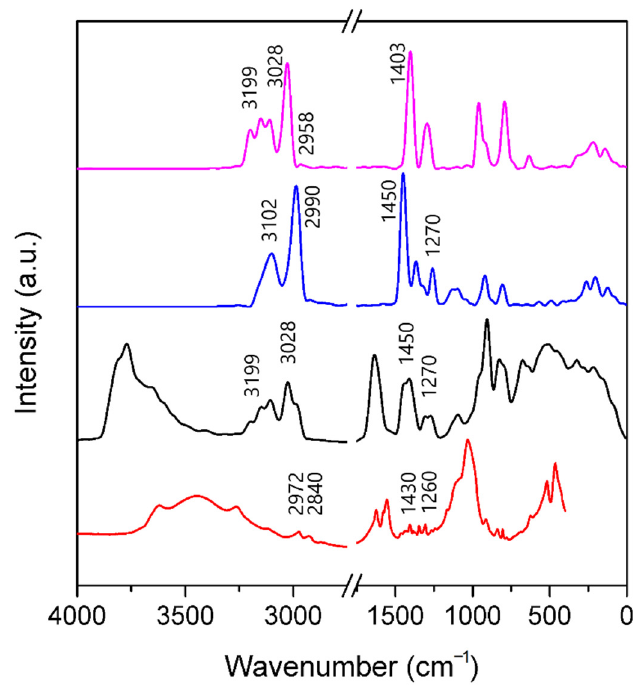
Figure 6. The contribution of the projected VDOS of C–H vibrations for the atrazine molecule (blue) and the TMP cation (magenta). The calculated total VDOS (black) and the experimental FTIR (red) for the A-TMP-Mt model.